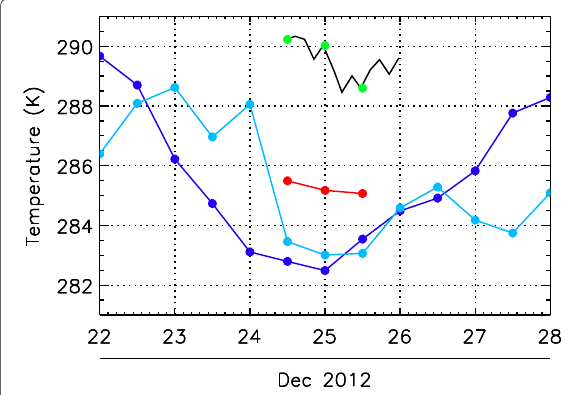
Fig. 4 Time series of the near-surface temperature during December 22–29, 2012. Values are the average between the surface and 850 hPa. (blue) Minamidaitojima, (light blue) Chichijima, (black) Hakuho-maru fixed-point observation data (3-hourly), (green filled circle) R/V Hakuho-maru data used in the budget analysis (12-hourly; 1200 UT on December 24, 0000 UT on December 25, and 1200 UT on December 25), (red) mean temperature obtained from the observations at the three site/stations (R/V Hakuho-maru, Minamidaitojima, and Chichijima)